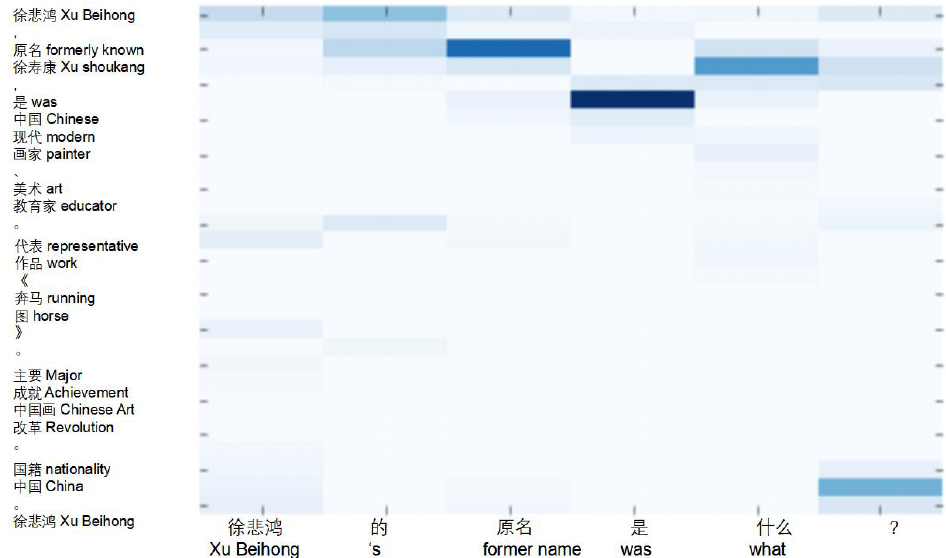
Figure 4. Attention distribution when Multi-encQG generated Q6.